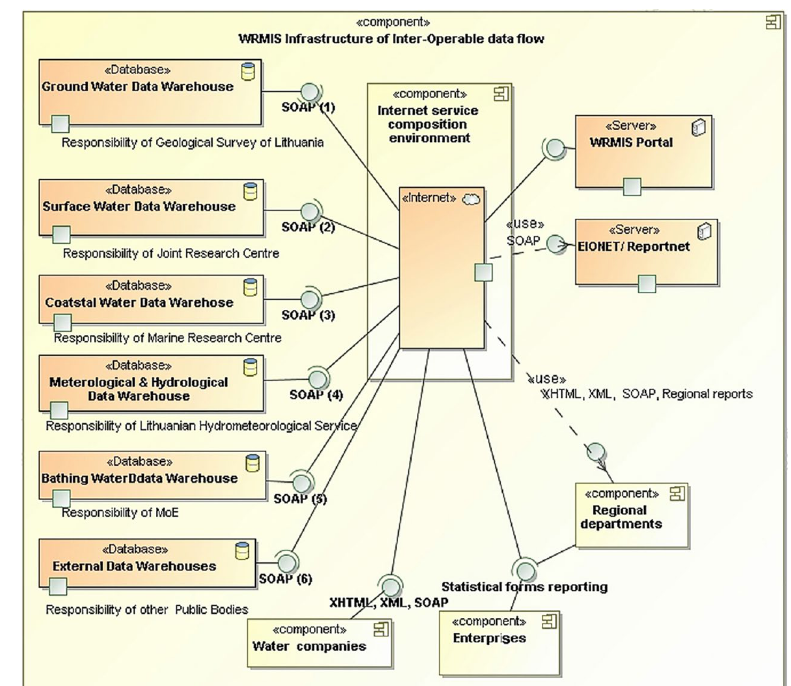
Fig. 5. The scheme of WRMIS inter-connections of main databases and